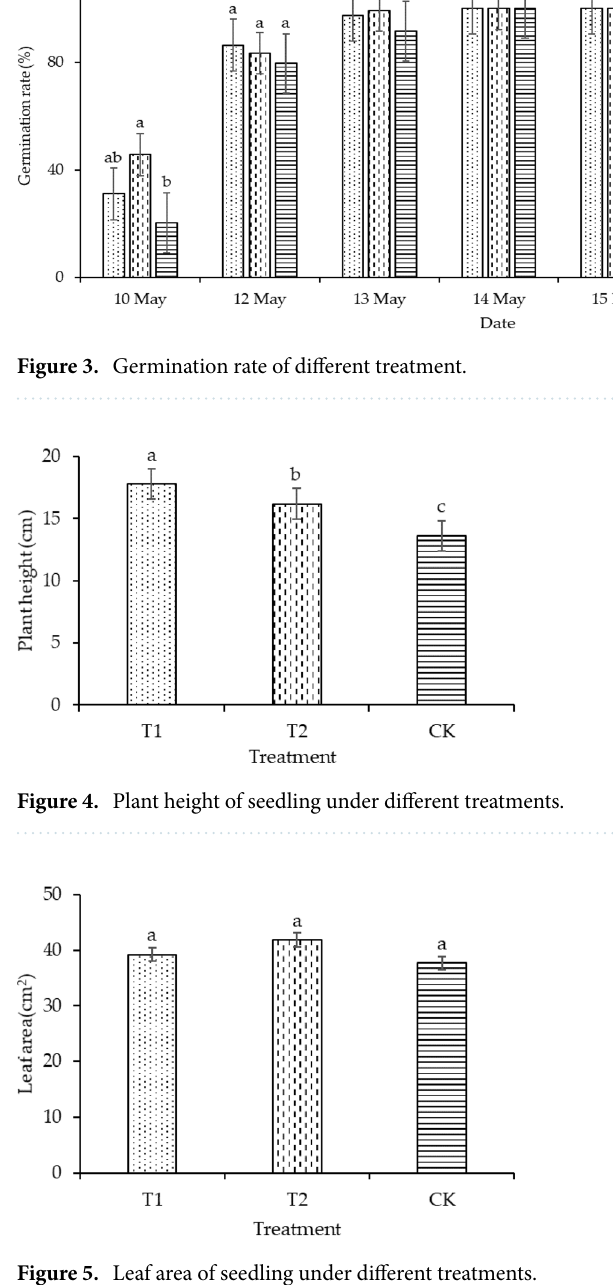
Figure 5. Leaf area of seedling under different